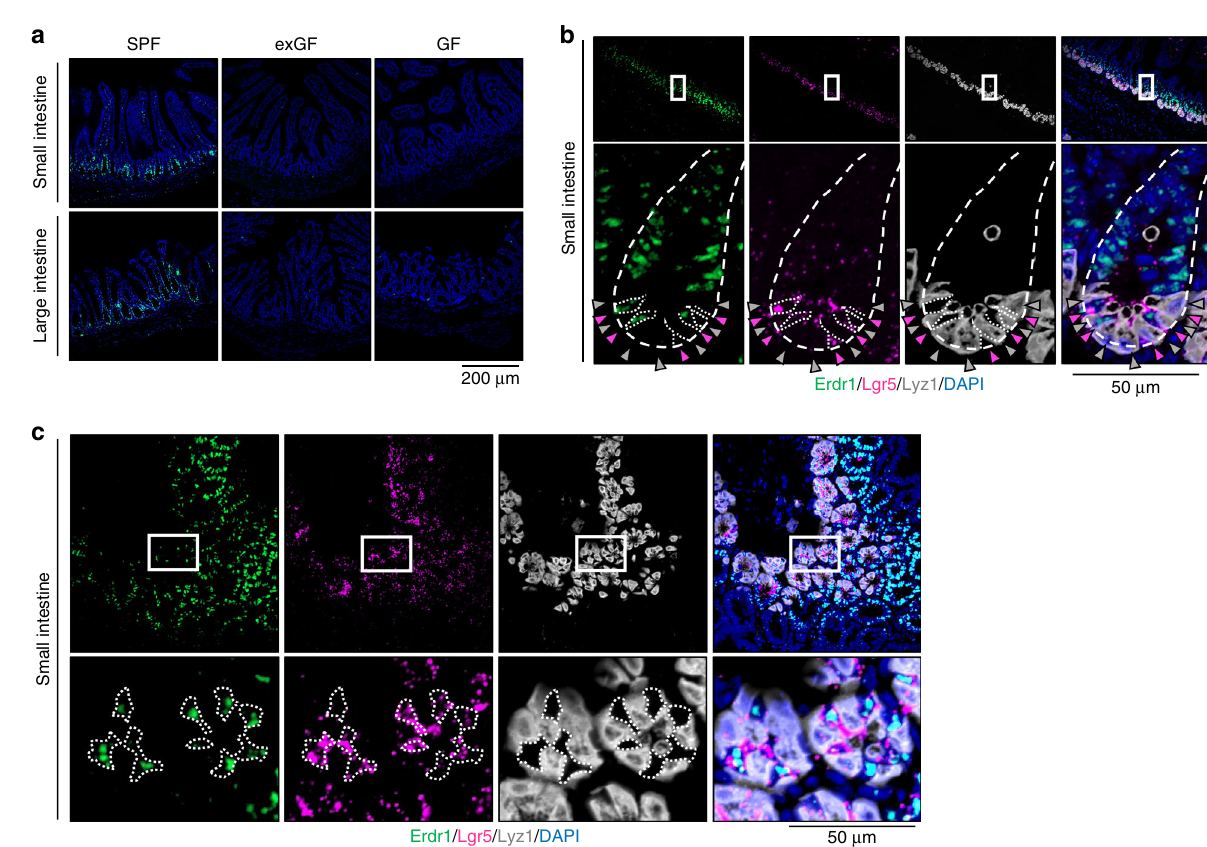
Fig. 2 Erdr1 is expressed in Lgr5 + intestinal stem cells (ISCs) and transit amplifying (TA) cells. a RNAscope staining for Erdr1 within small and large intestine from SPF, exGF, and GF mice. Green indicates Erdr1 RNA. b 3-color RNAscope staining of longitudinal sections of small intestine: green, Erdr1; pink, Lgr5; white, Lyz1; blue, DAPI. c 3-color RNAscope staining of transverse sections of small intestine, as in b